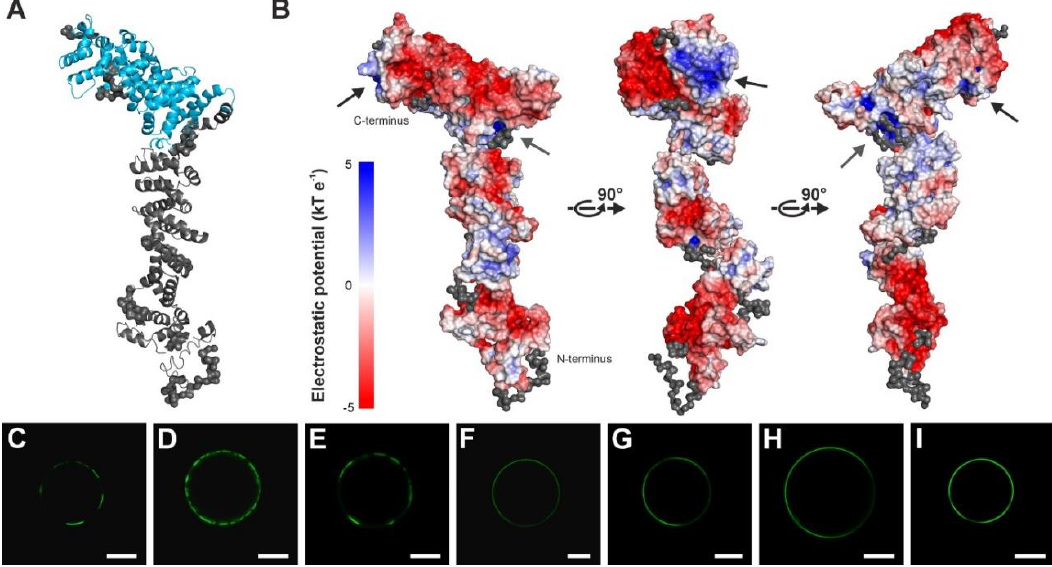
Figure 4. Structural model of the SAUL1 monomer. ( A ) EOM model of SAUL1. Potential ARM repeats 7–11, which are responsible for the localization of SAUL1 at the plasma membrane, are marked in blue. ( B ) Electrostatic potential of the solvent-accessible surface of SAUL1 in a range of ± 5 kT e −1 . Calculations were performed by splitting the obtained SAUL1 model into two regions: one containing the potential ARM repeats 7–11 and the rest of the protein in the other. Blue and red areas represent positively charged and negatively charged regions, respectively. The positively charged groove next to the C-terminus in the area of the potential ARM repeats 7–11, consisting of Arg736, Arg737, and Arg775, which is marked by a black arrow. ( C – I ) GFP signals of arginine mutants. GFP fluorescence in protoplasts following protein expression of the SAUL1 R775A single mutant ( C ), the SAUL1 R737A single mutant ( D ), the SAUL1 R737A/R775A double mutant ( E ), the SAUL1 R736A single mutant ( F ), the SAUL1 R736A/R775A double mutant ( G ), the SAUL1 R736A/R737A double mutant ( H ), and the R336A/R737A/R775A triple mutant ( I ). Scale bars in ( C ) to ( I ) represent 15 µm.